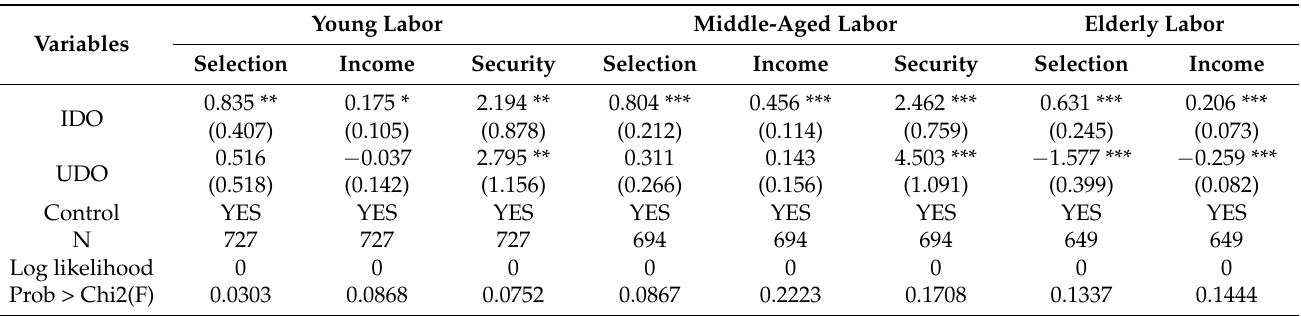
Table 5. Results of the impact of heterogeneous land development opportunities on the employment of labor force of different